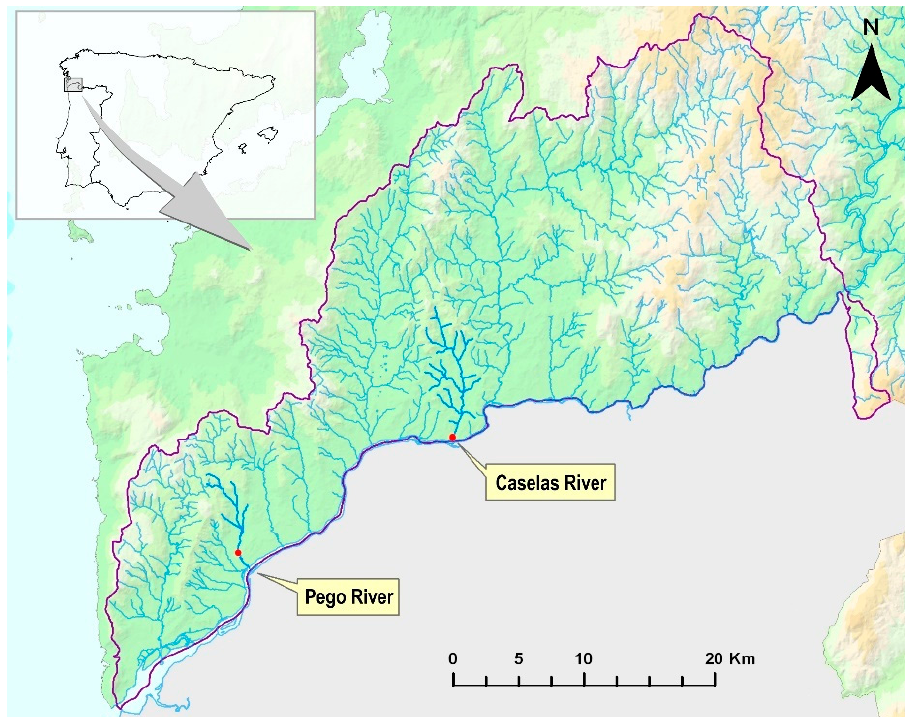
Figure 1. Location of the two studied tributaries in the final section of the Miño River.